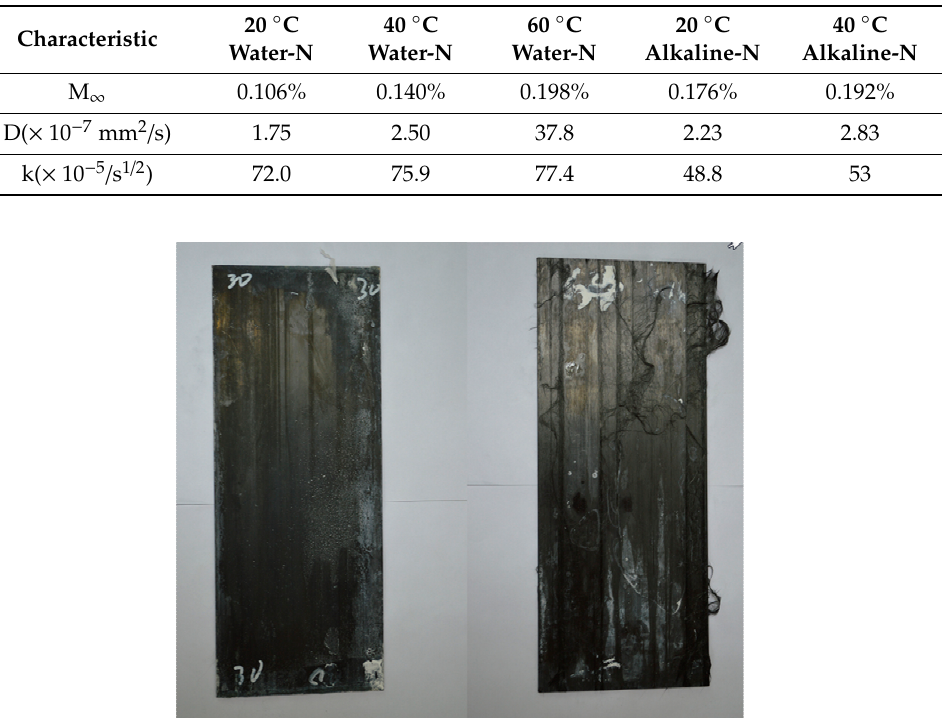
Table 2. Di ff usion parameters of naked CFFR plates. Table 2. Diffusion parameters of naked CFFR plates.